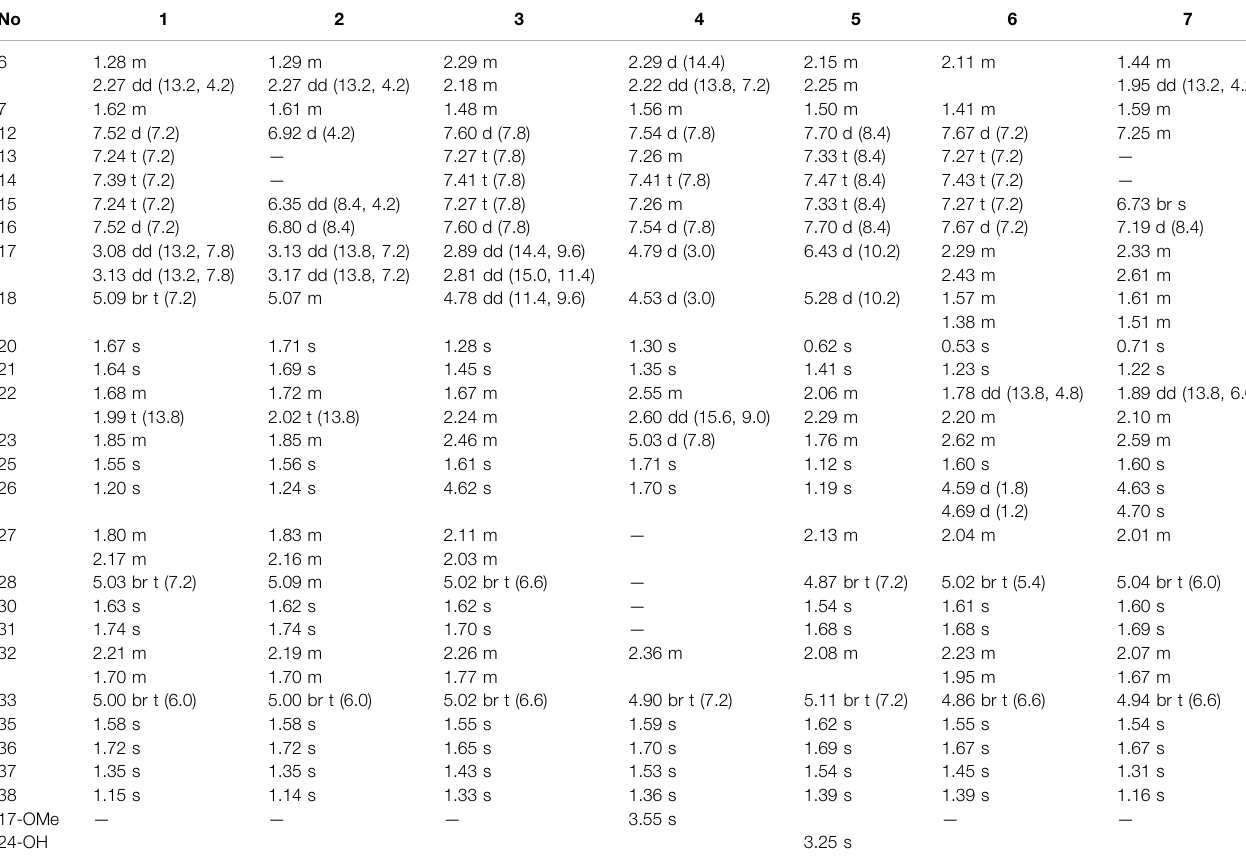
TABLE 2 | 1 H NMR data of compounds 1 – 7 in CDCl 3 (600 MHz, δ in ppm, J in